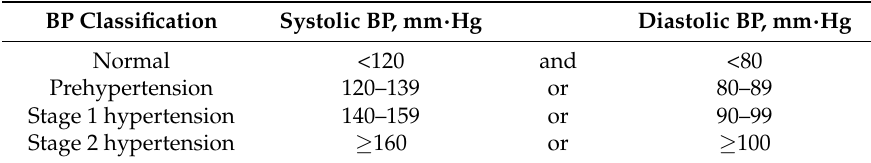
Table 1. Classification of blood pressure in JNC 7.